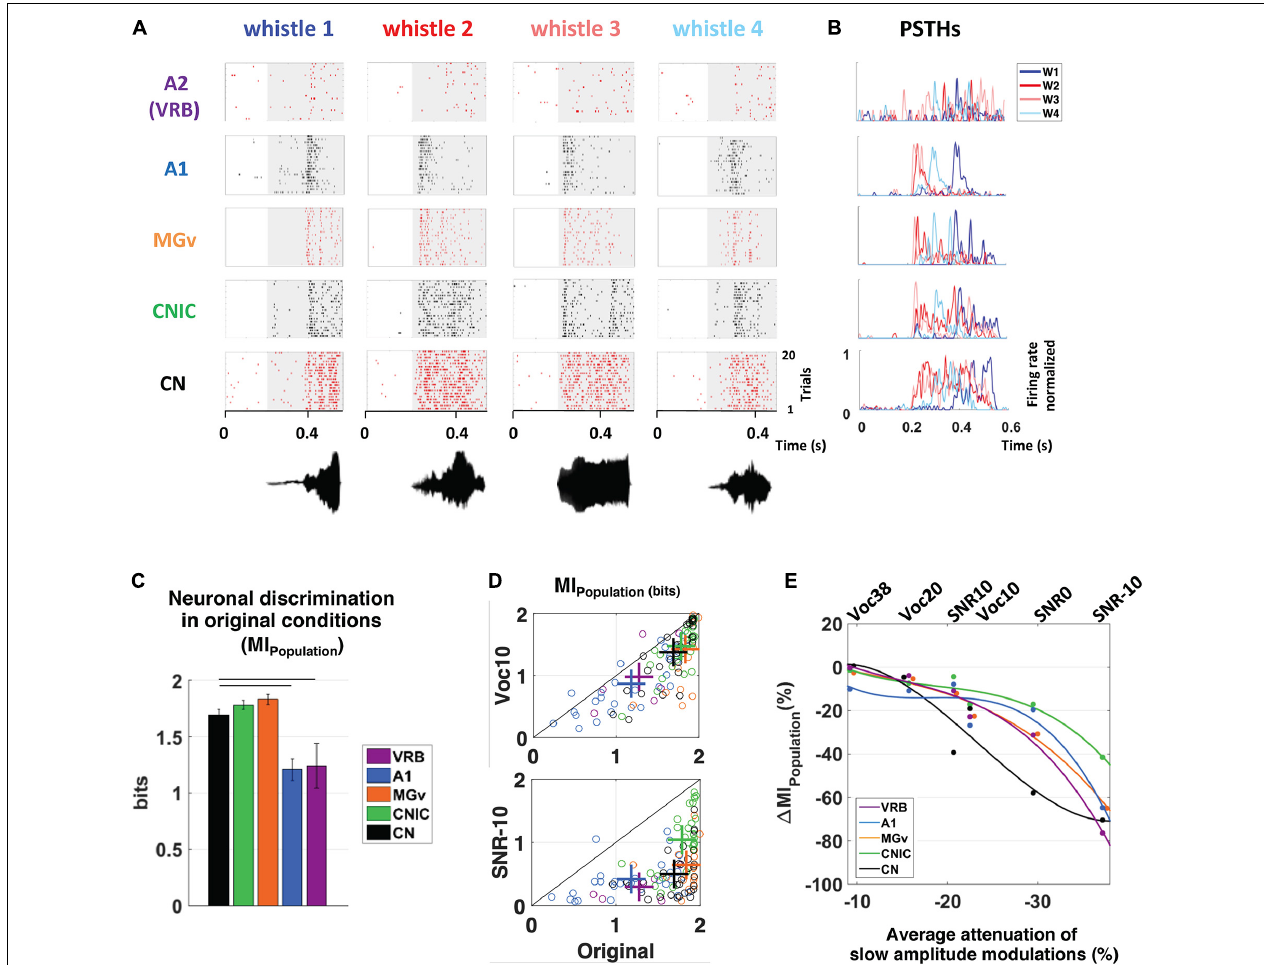
FIGURE 1 | Subcortical neurons better discriminate the vocalizations in quiet as well as in degraded conditions and alterations of slow amplitude modulations are crucial cues for explaining the decrease in discrimination performance at the subcortical and cortical levels. (A) From bottom to top, raster plots presenting the neuronal responses recorded in CN, CNIC, MGv, A1, and VRB. Each dot represents an action potential and each line the presentation of one of four original whistles. The gray areas correspond to the evoked activity. The waveforms of the four original whistles are displayed under the raster plots. (B) Peristimulus time histograms (PSTHs) of the neuronal responses presented in (A) . For all neuronal recordings, the four PSTHs corresponding to the four original whistles have been overlayed. (C) The mean values of the neuronal discrimination at the population level (MI Population , bits) are presented for populations of 9 simultaneous multiunit recordings obtained with the four original vocalizations in CN (in black), CNIC (in green), MGv (in orange), A1 (in blue), and VRB (in purple). Error bars represent the SE of the mean and horizontal black lines represent the statistically significant differences. Note that, all the subcortical structures discriminate better the original vocalizations than cortical areas. (D) Scattergrams showing the modest decrease in MI Population (bits) with the most severe vocoded condition (Voc10, top panel) compared to the strong decrease with the most severe noisy condition (SNR-10, bottom panel). Each cross represents the mean MI Population obtained in degraded and original conditions. (E) Percentage of alterations in neuronal population discrimination abilities ( (cid:49) MI Population ) as a function of the alterations in slow amplitude modulations induced by vocoding (Voc38, Voc20, and Voc10) or by the addition of stationary noise (SNR10, SNR0, and SNR-10). Each dot represents neuronal data ( (cid:49) MI Population ) in CN (in black), CNIC (in green), MGv (in orange), A1 (in blue) and VRB (in purple). Polynomial curves fitting all acoustic conditions have been generated (color lines). In all conditions (vocoding or noise), there is a limit of AM reduction from which the (cid:49) MI Population decreases in cortical and subcortical structures. Thus, the reduction of slow AM cues is one of the factors explaining the neuronal discrimination performance at the subcortical and cortical levels. Modified from Souffi et al. (2020). CN, cochlear nucleus; CNIC, central nucleus of the inferior colliculus; MGv, ventral division of the medial geniculate nucleus; VRB, ventrorostral belt (secondary auditory